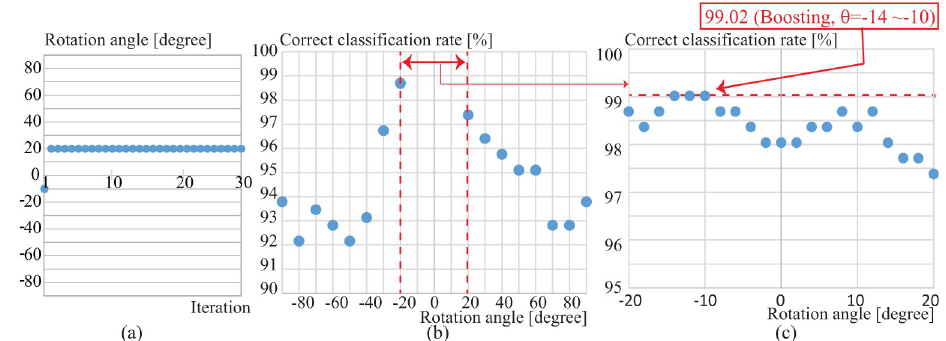
Fig 12. (a) Selected rotation angle at each iteration by the boosting method, (b) correct classification rate (CCR) at each rotation angle (-90 � θ � -20 and 20 � θ � 90), and (c) CCR at each rotation angle (-20 � θ � 20) (the dotted line shows the CCR by fusing all rotation angles by the boosting method).